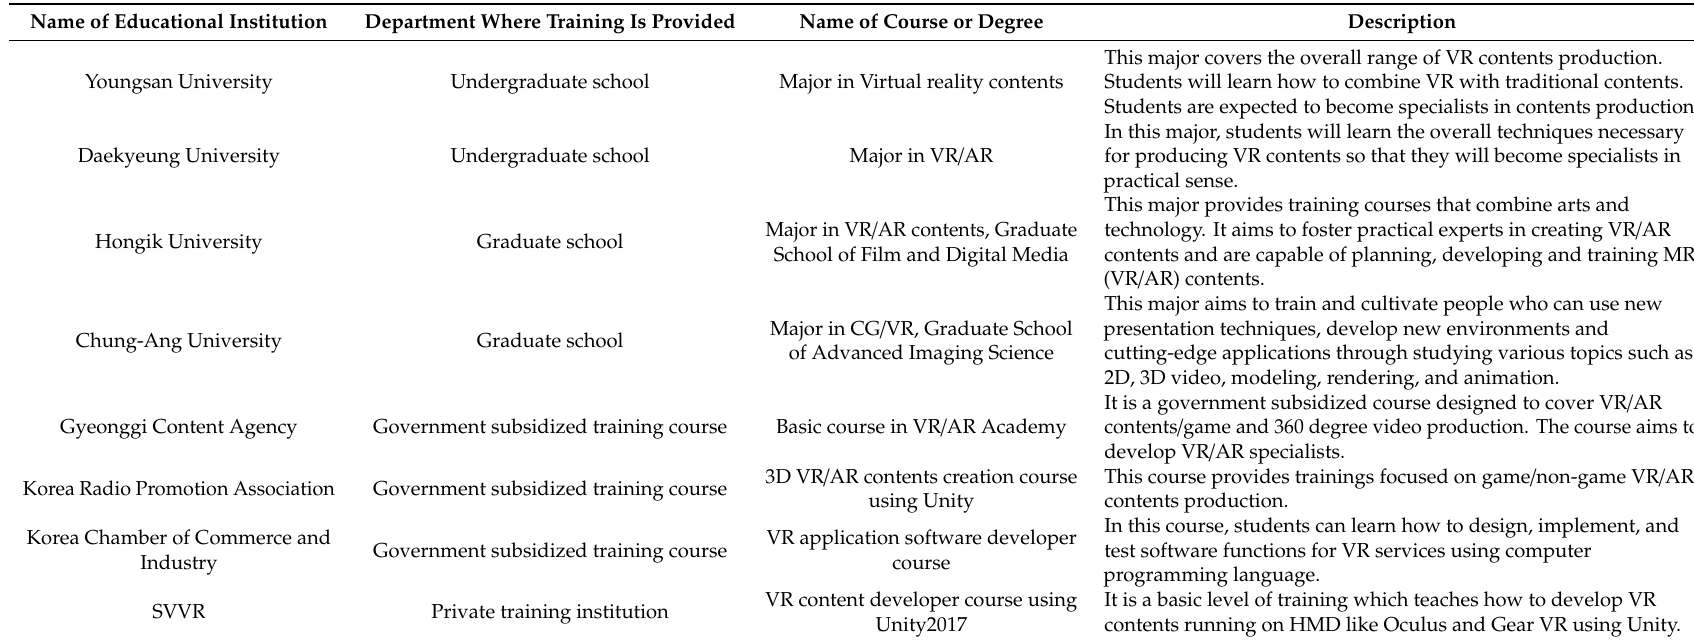
Table 2. Educational institutions and courses related to VR